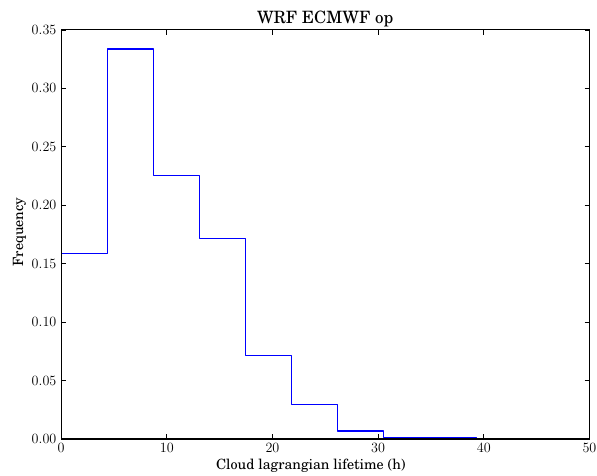
Figure 10. Distribution of in-cloud residence time for air parcels, estimated from Lagrangian trajectories launched on 28 January 2009, 12:00, in the reference simulation and calculated forward and backward. Parcels were considered in cloud when the ice water con- tent was bigger than 1 × 10 − 8 kgkg − 1